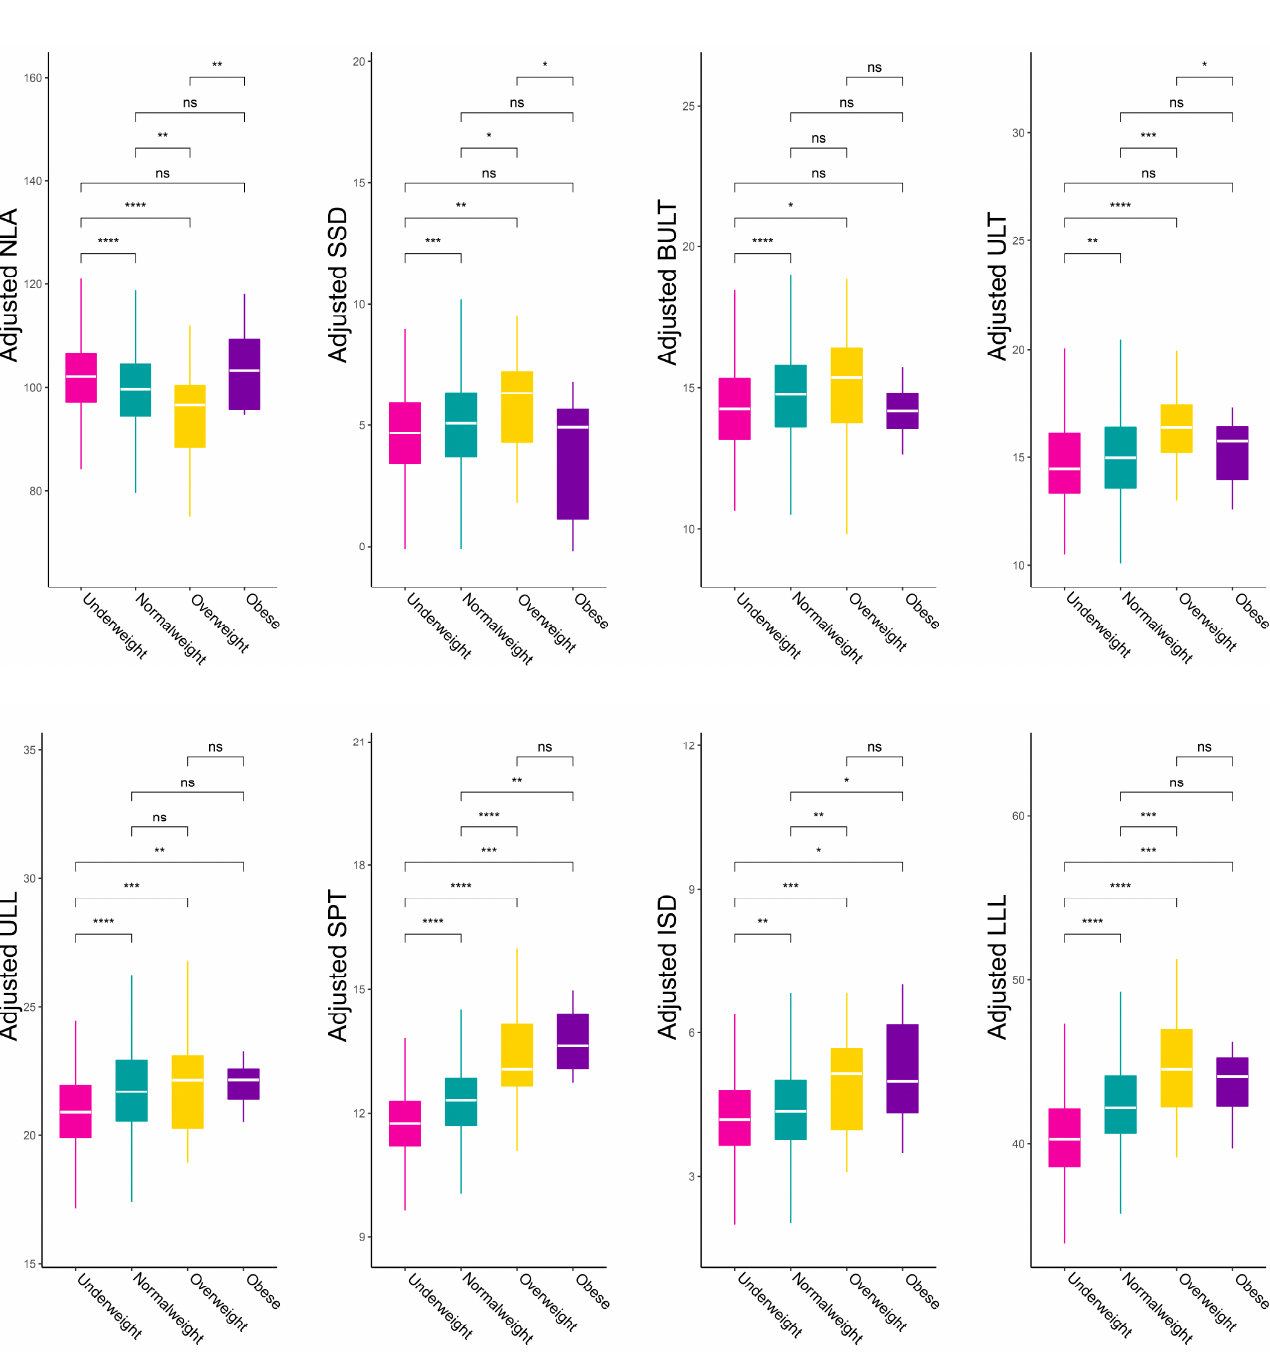
Figure 5. The comparations of multivariate regression analysis adjusted for eight lip characteristics among four BMI categories. NLA: Nasolabial angle, SSD: Superior sulcus depth, BULT: Basic upper lip thickness, ULT: Upper lip thickness, ULL: Upper lip length, SPT: Soft pogonion thickness, ISD: Inferior sulcus depth, LLL: Lower lip length, BMI: Body mass index. ns: p >= 0.05, *: p < 0.05, **: p < 0.01, ***: p < 0.001, ****: p < 0.0001.